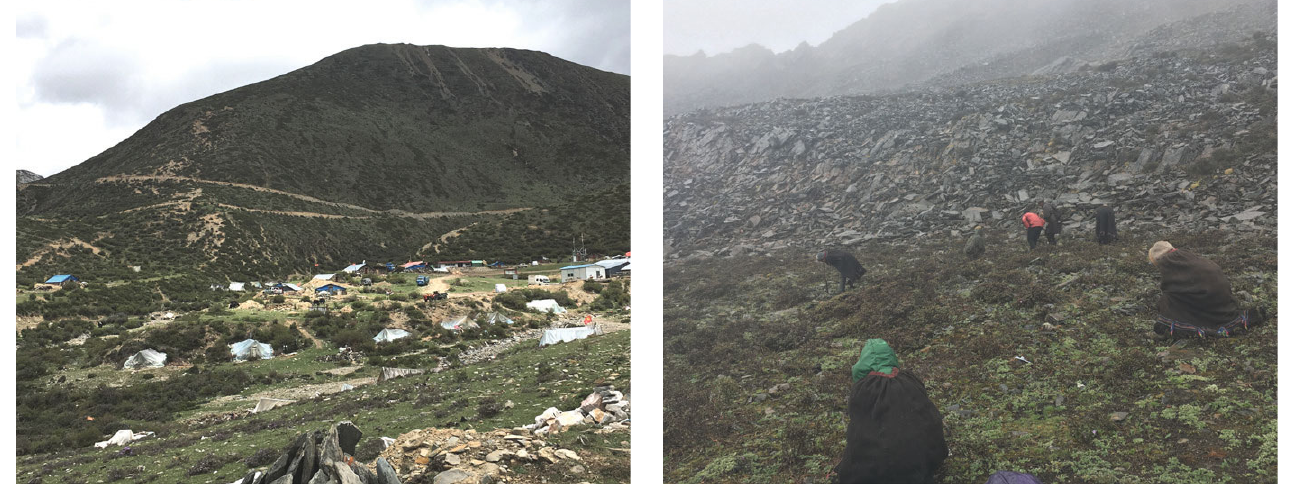
Fig. 3. Camp ground: Villagers from neighboring areas are only allowed to set up tents, while the villagers who own these mountains can build houses. Photo: Siran Liang,